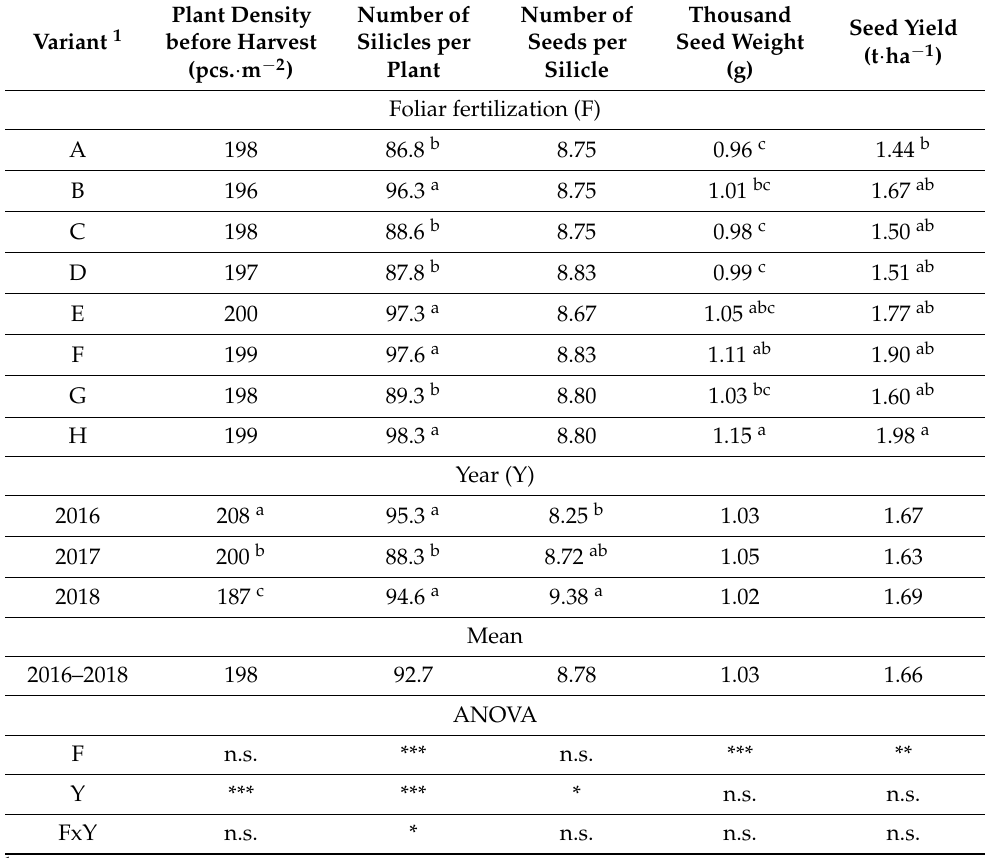
Table 3. Yield components and seed